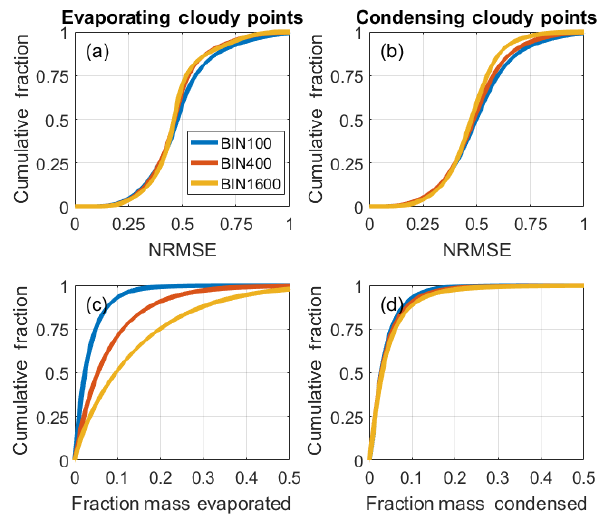
Figure 6. Cumulative distributions of (a, b) NRMSE, (c) fraction of mass evaporated, and (d) fraction of mass condensed. Panels (a, c) include only grid points where evaporation occurred and (b, d) in- clude only grid points where condensation occurred.